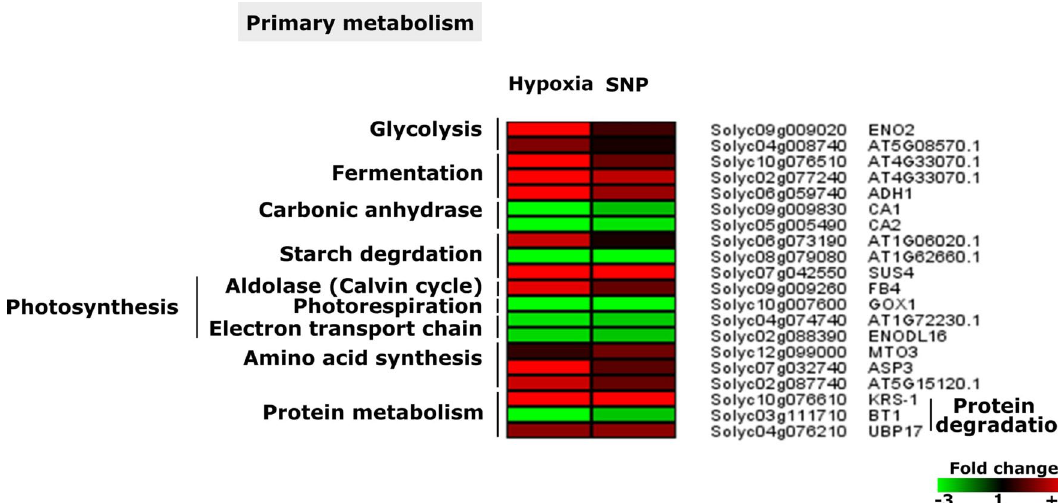
Figure 7. Hypoxia- and SNP-induced and repressed genes associated with primary metabolism. Heat maps display the up-regulated (red bars) or down-regulated (green bars) tomato genes and their Arabidopsis thaliana homologs. Depicted are differentially expressed genes (Padj < 0.05) (n = 3 ). ENO2 , ENOLASE2 ; ADH1 , ALCOHOL DEHYDROGENASE 1 ; CA1 , CARBONIC ANHYDRASE 1 ; CA2 , CARBONIC ANHYDRASE 2 ; SUS4 , SUCROSE SYNTHASE 4 ; FB4 , AUXIN SIGNALING F-BOX 4 ; GOX1 , GLYCOLATE OXIDASE 1 ; ENODL16 , EARLY NODULIN-LIKE PROTEIN 16 ; MTO3 , METHIONINE OVER-ACCUMULATOR 3 ; ASP3 , ASPARTATE AMINOTRANSFERASE 3 ; KRS.1 , LYSYL-TRNA SYNTHETASE 1 ; BT1 , BTB AND TAZ DOMAIN PROTEIN 1 ; UBP17 , UBIQUITIN-SPECIFIC PROTEASE 17